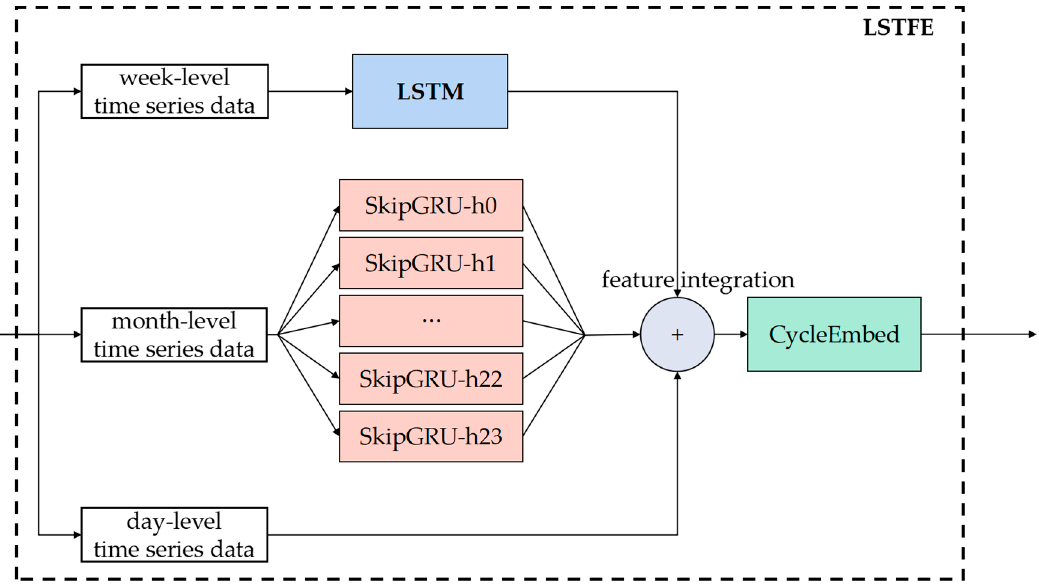
Figure 4. The structure of LSTFE module.